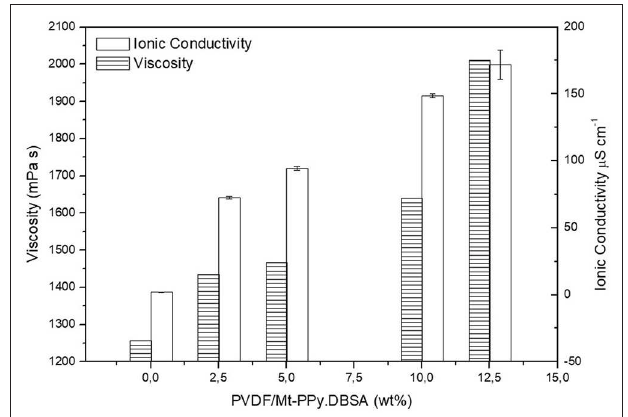
FIGURE 1 | Viscosity (left axis) and ionic conductivity (right axis) of the solution containing different amount of Mt-PPy.DBSA.